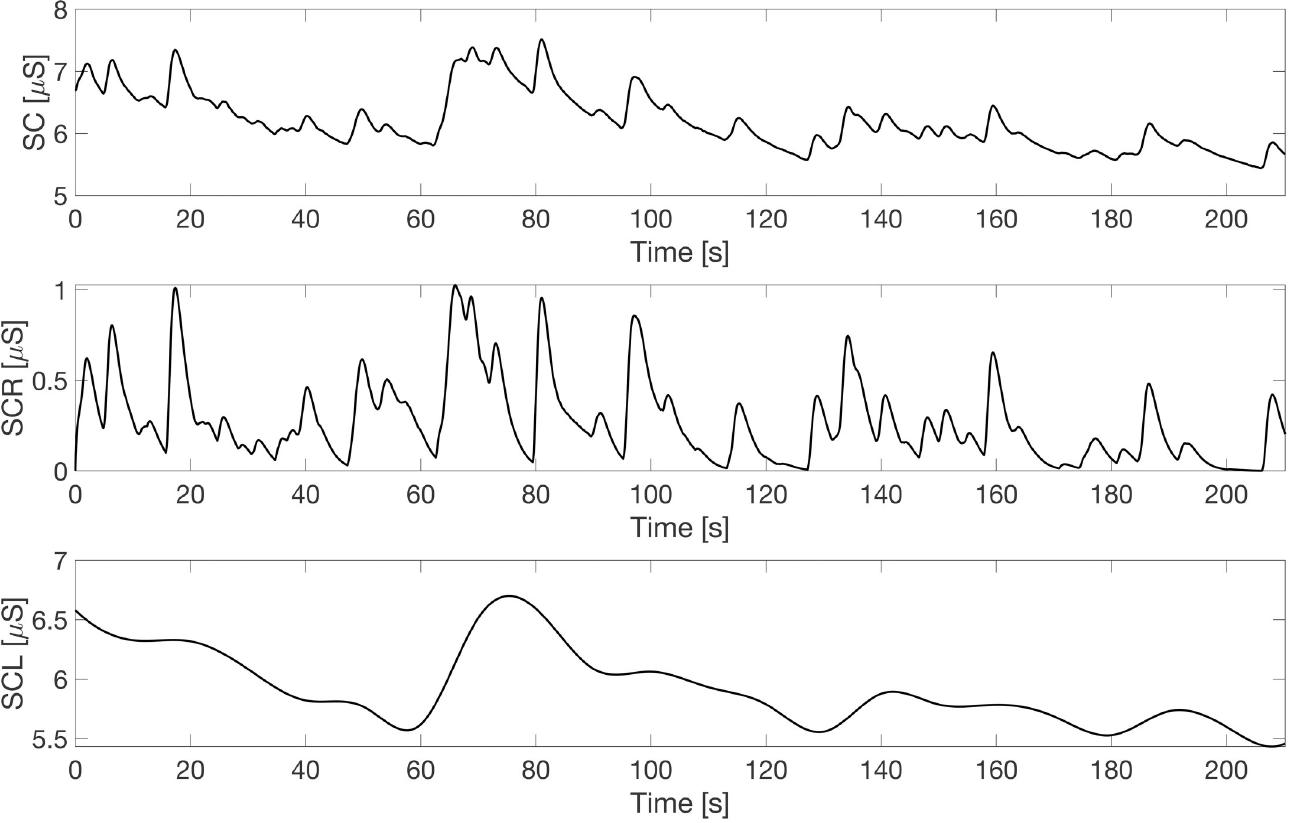
Fig 4. Skin conductance. The SC signal (top panel) is decomposed in its 2 components, the phasic SCR (middle panel) and the tonic SCL (bottom panel).